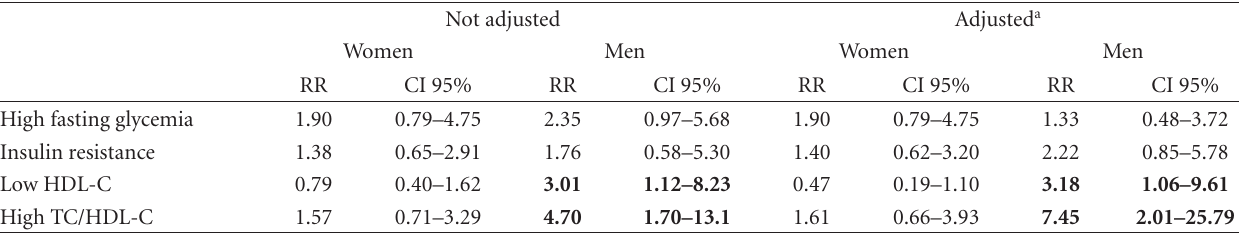
Table 5: Onset of cardiometabolic risk factors over the followup period before and after adjusting for WC changes, age, diet, and lifestyle ( n = 366).